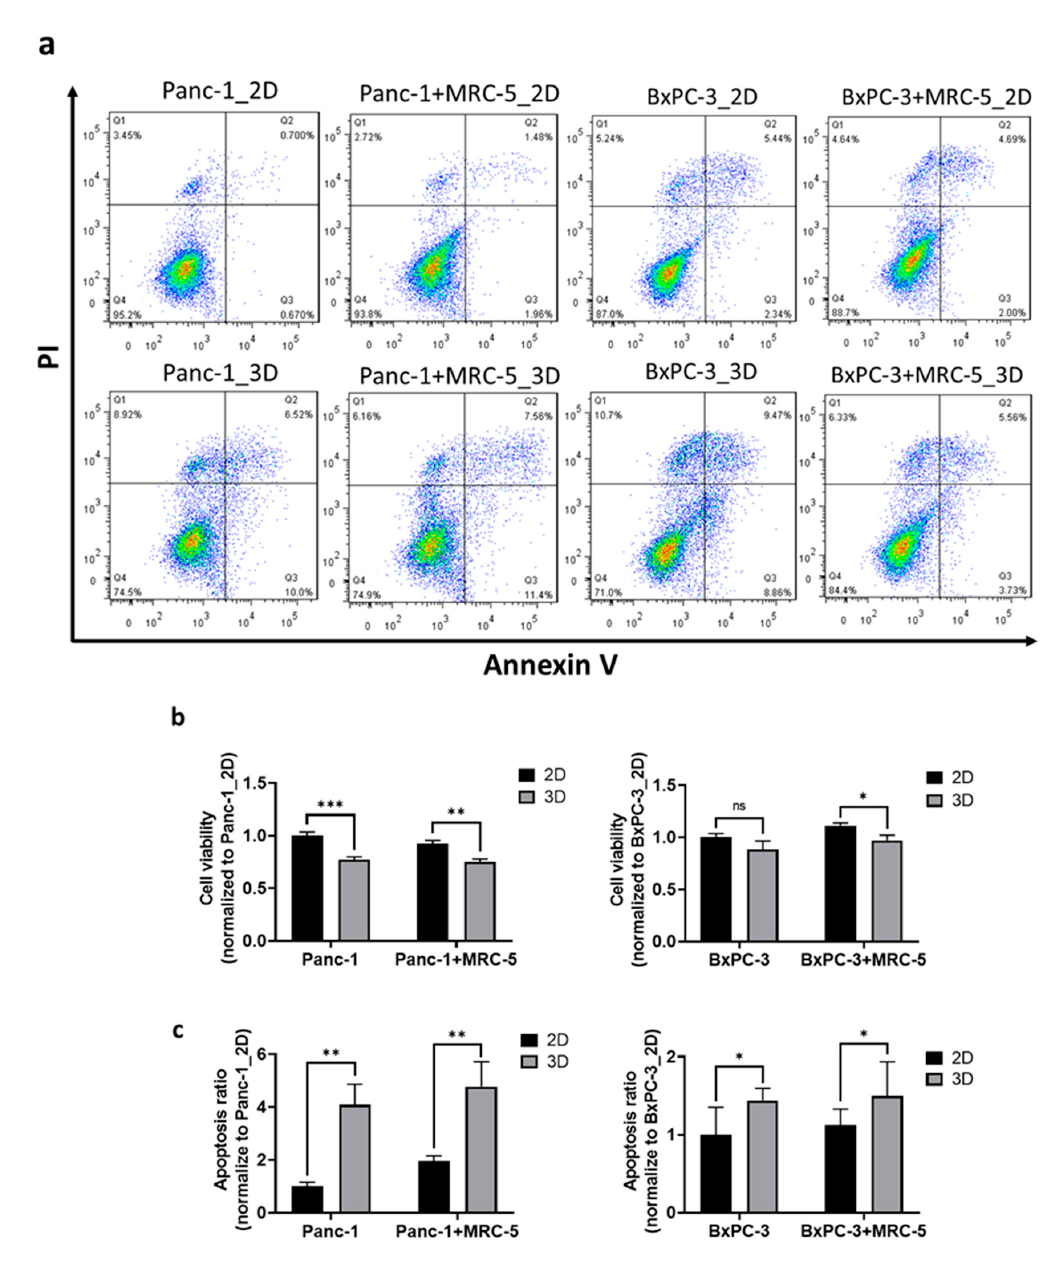
Figure 2. The pancreatic cancer cell expressed obvious BNCT susceptibility in an in vitro 3D culture system. ( a ) The density plot of flow cytometry results collected from cells stained with apoptosis marker annexin V (FITC) and nucleus marker propidium iodide (PI). X -axis and Y -axis represent the intensity of FITC-annexin V and PI, respectively. Each dot presents a cell and is allocated at the coordinate according to its relative fluorescent intensity level. Pseudo-color was added to show the population distribution. The quantitative results of ( b ) cell viability and ( c ) apoptosis in Panc-1 and BxPC-3 normalized to their 2D monolayer groups. Statistical significance was determined by t -test. ns, non-significant; * p < 0.05, ** p < 0.01, *** p < 0.001.